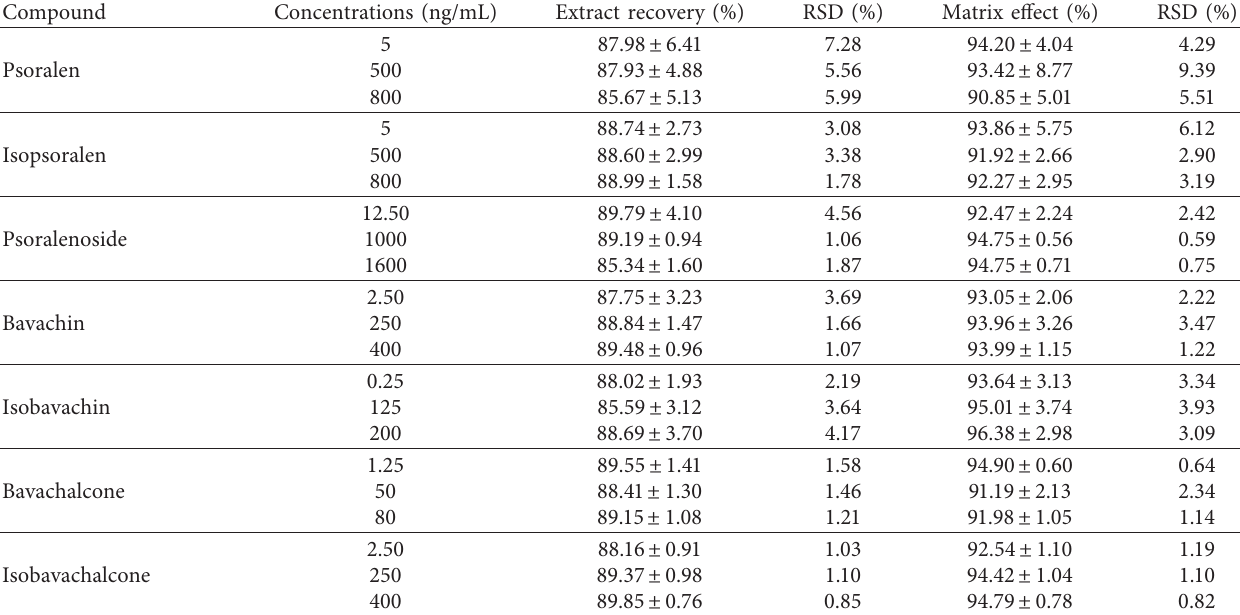
Table 4: The extract recoveries and matrix effect of 12 compounds in rat kidney ( n �